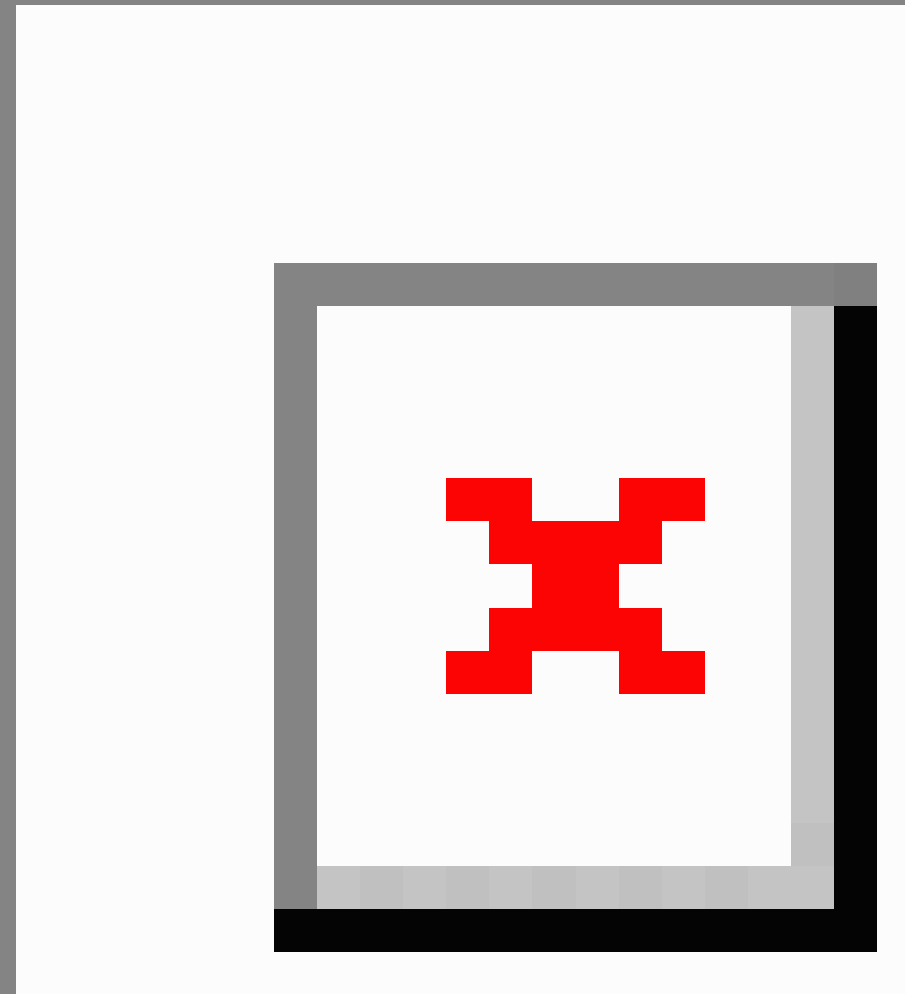
Figure 4. Example of a potential violation of patient